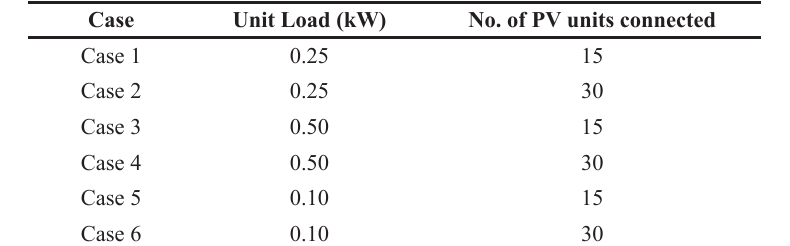
Figure 6: Comparison of simulation results with actual measurements. Table 1: Cases